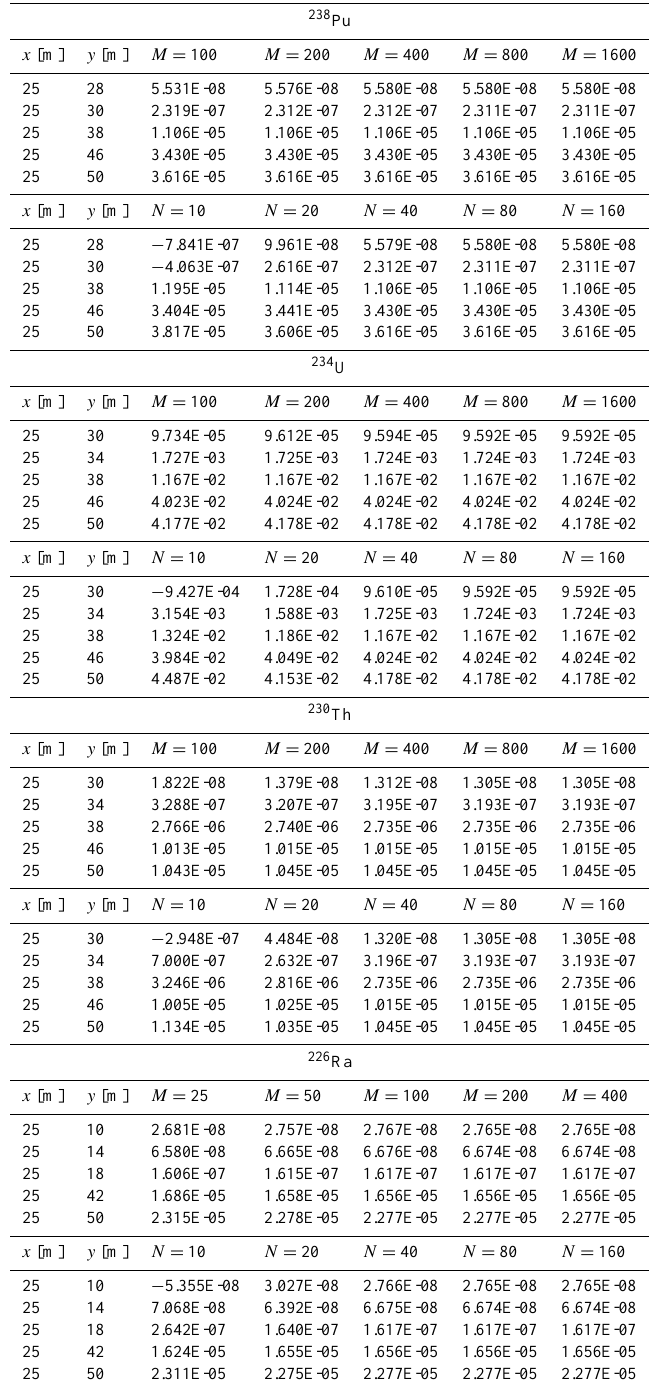
Table 4. Solution convergence of each species concentration at transect of x = 25m for four-species radionuclide transport problem considering simulated domain of L = 250m, W = 100m, subject to Bateman-type sources located at 40m ≤ y ≤ 60m for t = 1000year ( M = number of terms summed for inverse generalized integral transform; N = number of terms summed for inverse finite Fourier cosine transform). When we investigate the required M for inverse generalized integral transform, N = 160 for the finite Fourier cosine transform inverse are used. When we investigate the required N for inverse finite Fourier cosine transform, M = 1600 for the generalized transform inverse are